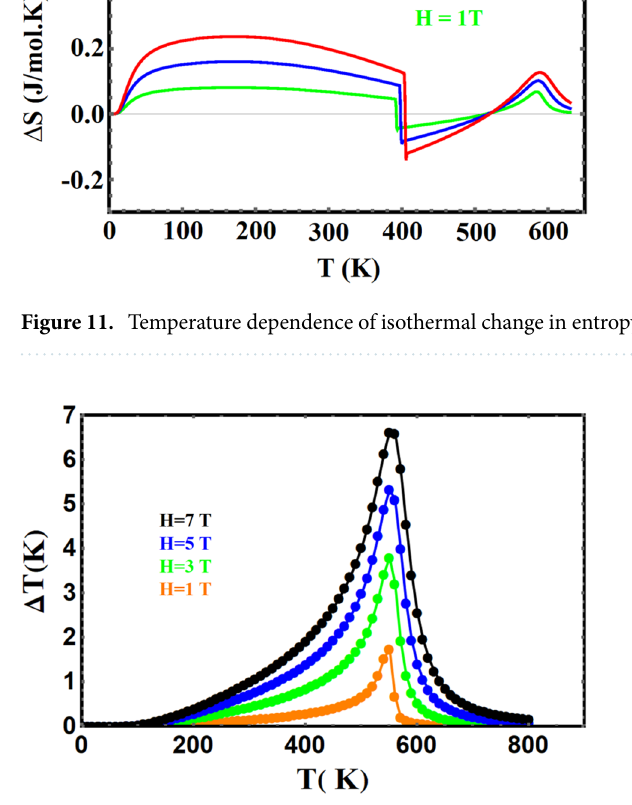
Figure 12. The field-dependence of the adiabatic change in temperature vs. temperature for YFe 3 .